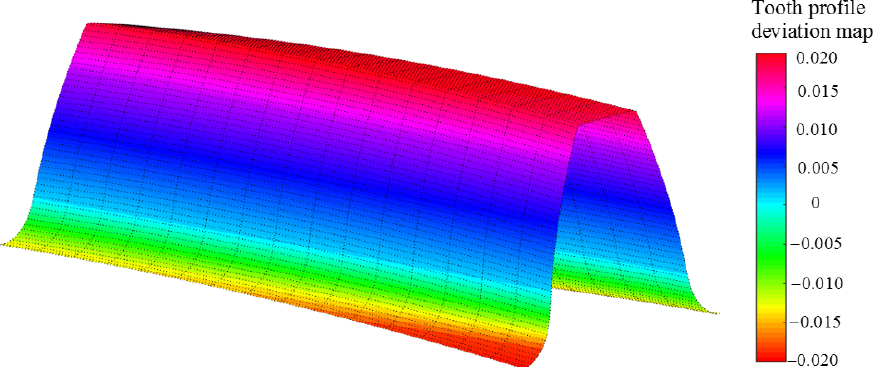
Figure 14. Overall deviation color mapping on the tooth profile surface.